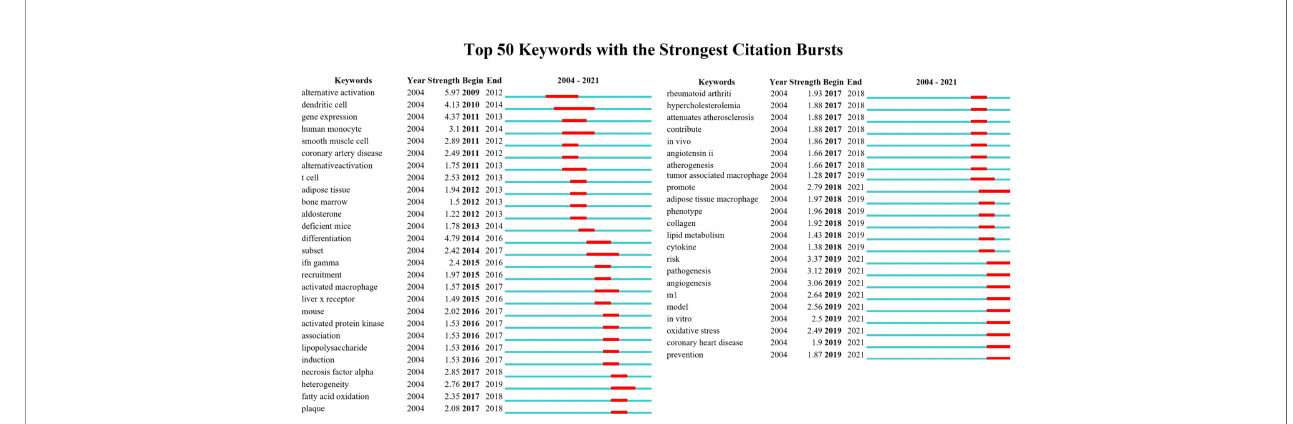
FIGURE 8 | Top 50 keywords with citation burst (sorted by the beginning year of the burst).